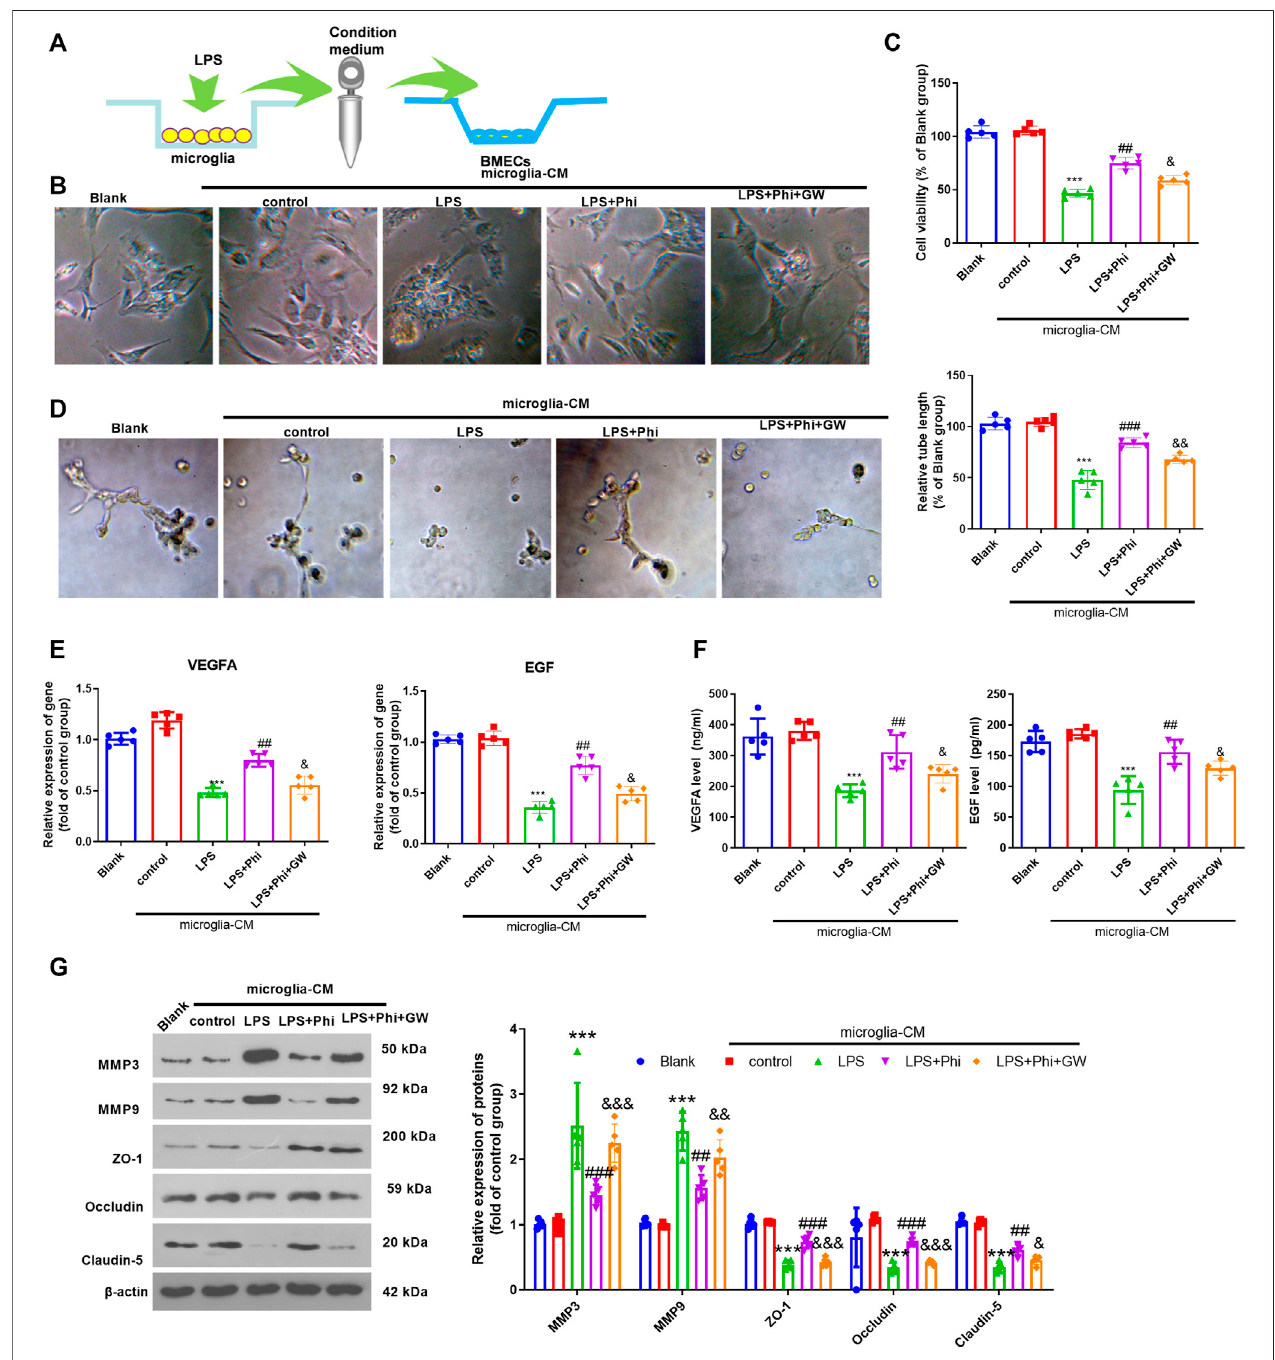
FIGURE4| PhipromotedBMECs viabilityandtube formationabilityviaPPAR γ inmicroglia. (A) Microglia weretreatedwithLPS (10 ng/ml)or phillyrin(40 μ g/ml) or GW9662(1 μ M) for 4 h. BMECs were treated with the culture medium from microglia. (B) Morphological changes of BMECs were recorded by using a light Olympus microscope. (C) Cell viability of BMECs was detected by CCK-8 assay. (D) Tube formation assay was performed to evaluate the tube formation ability of BMECs. (E , F) RT-PCR and ELISA were conducted to measure VEGFA and EGF in BMECs or the culture medium. (G) Expressions of MMP3, MMP9, ZO-1, occludin, and claudin-5 inBMECswere evaluatedvia Western blot. The values are expressed as mean ± SD. *** p < 0.001 vs. the control-CM group; ## p < 0.01, ### p < 0.001 vs. the LPS-CM group; & p < 0.05, && p < 0.01, &&& p < 0.001 vs. the LPS+Phi-CM group. n (cid:1) 5/group.